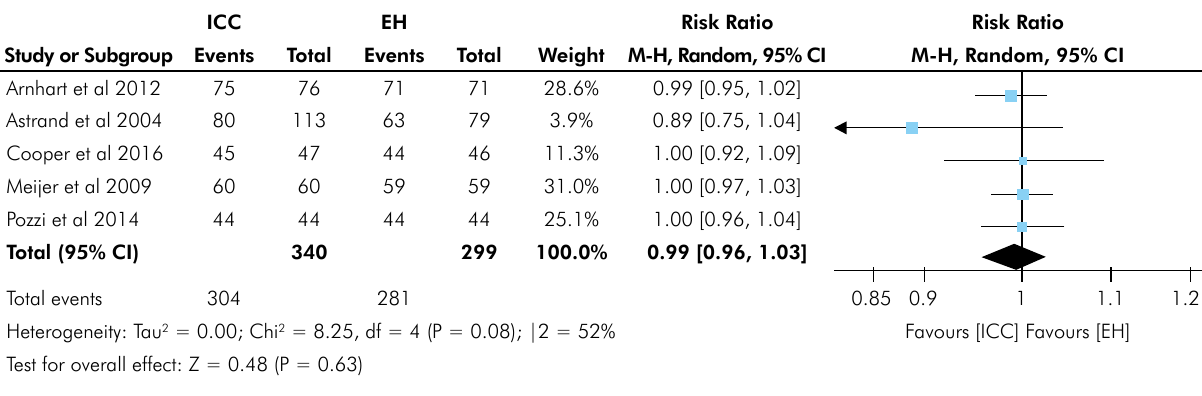
Figure 7. Implant survival rates after 3